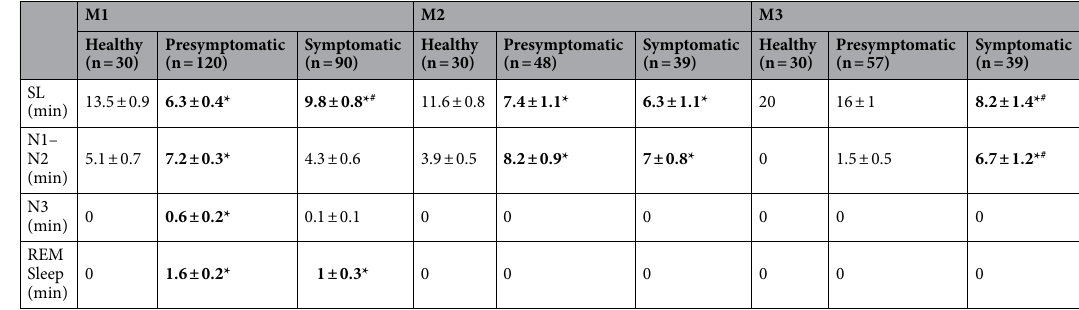
Table 2. Sleep parameters obtained in lights-OFF sessions for each animal M1, M2 and M3 during healthy, presymptomatic and symptomatic states. Sleep parameters obtained in lights-OFF sessions for each animal during healthy, presymptomatic and symptomatic states expressed in mean values (± SEM) derived from lights-OFF sessions pooled together for each condition and animal (n are indicated in parentheses). SL refer to the time in minute between the lights turned off and the first sleep episode. Values in lines 2, 3 and 4 are expressed as the mean duration ± SEM in min for each sleep stages (N1 and N2 pooled together, N3 and REM sleep). P < 0.05 * different from healthy state; # different from presymptomatic state: Kruskal–Wallis test followed by Dunn’s multiple comparisons test in the event of statistically significant differences. Significant values are in bold.